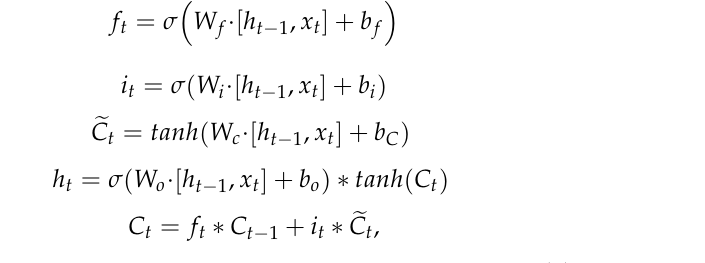
Figure 6. GRU architecture schematic. The data are processed as shown in the following equations: 𝑧 (cid:3047) = 𝜎(𝑊 (cid:3053) ⋅ (cid:4670)ℎ (cid:3047)(cid:2879)(cid:2869) , 𝑥 (cid:3047) (cid:4671))